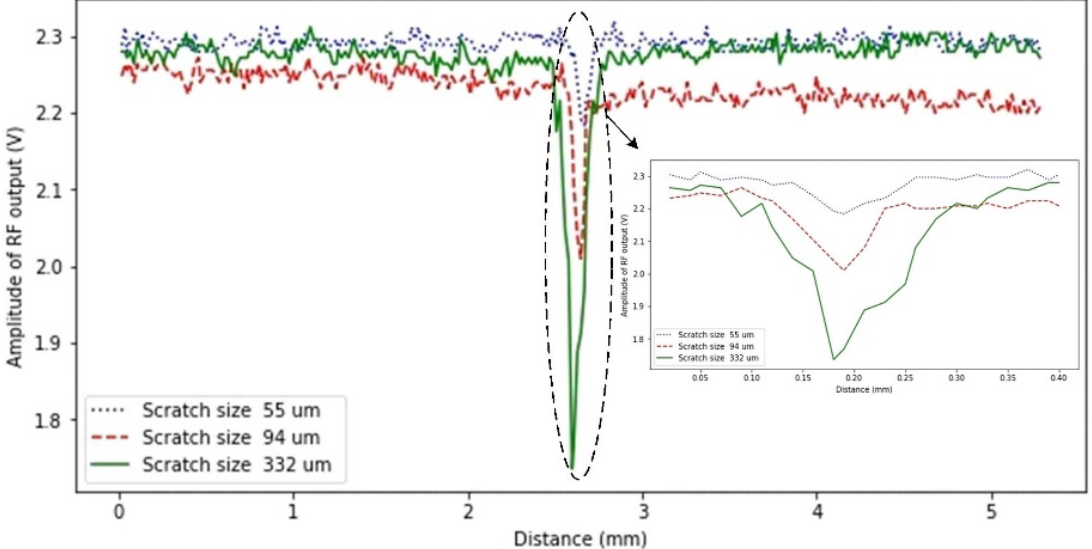
Figure 8. Distance and amplitude measurements of 3 scratches detected by the DVD pick-up head. Table 2. Comparisons of width measurements and percentage errors of 3 scratches measured by CD, DVD, SM, and